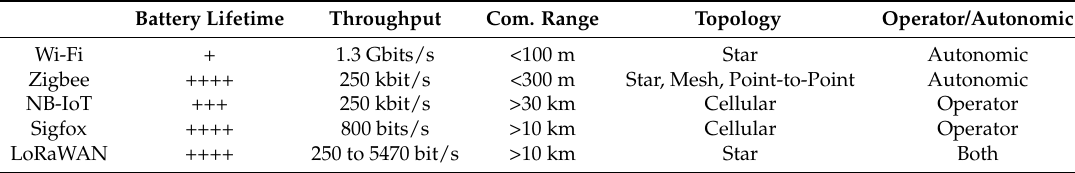
Table 3. Comparison of different network technologies.